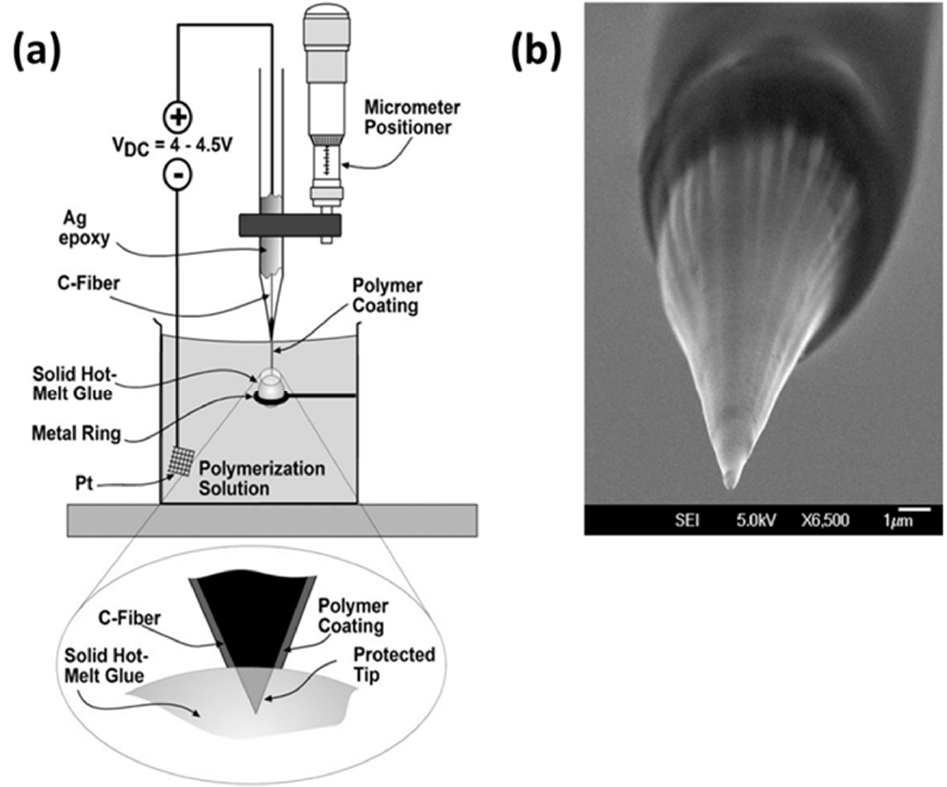
Figure 2. pH SECM microelectrode fabrication and protection: ( a ) Schematic diagram for the tip protection step right before electropolymerization of poly(oxyphenylene) onto the rest of the electrode, ( b ) SEM micrograph of the poly(oxyphenylene) protected carbon fiber UME. Reprinted from ref. [42]. Copyright (2006) with permission from John Wiley and Sons.